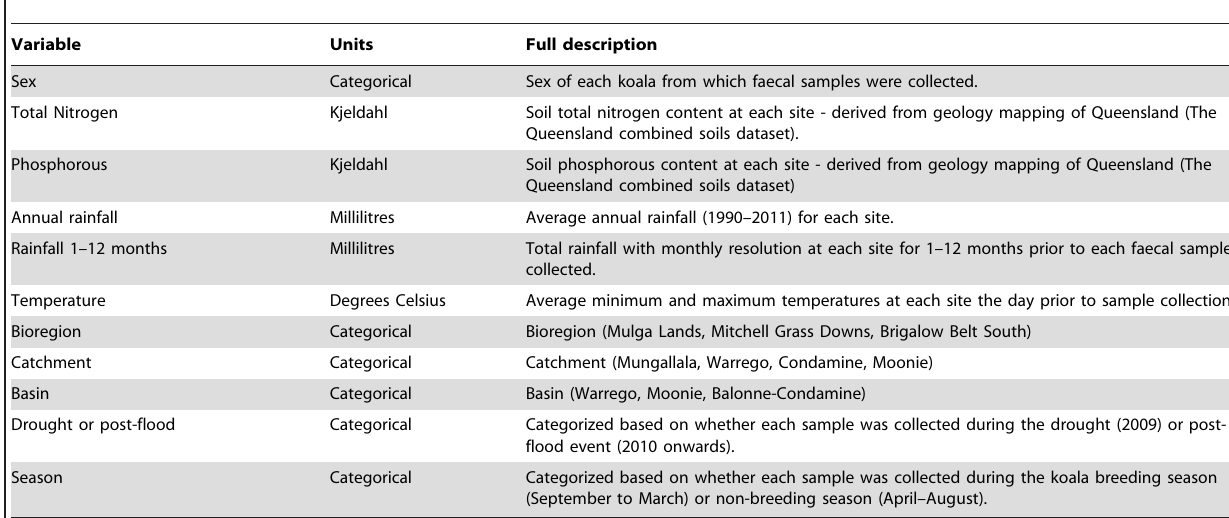
Table 1. Explanatory variables used to examine variation in faecal cortisol concentrations.